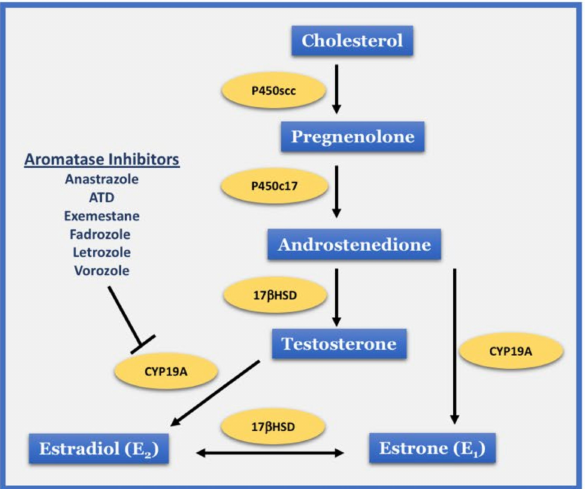
Figure 1. Simplified representation of the pathway for estrogen biosynthesis. Estrogen synthesis begins with conversion of cholesterol to pregnenolone. Through multiple steps, pregnenolone is converted into androstenedione, which is converted into testosterone and estrone (E 1 ). Testosterone is then converted into 17 β -estradiol (E 2 ) through the action of aromatase (CYP19A). Brain aromatase can be inhibited by various aromatase